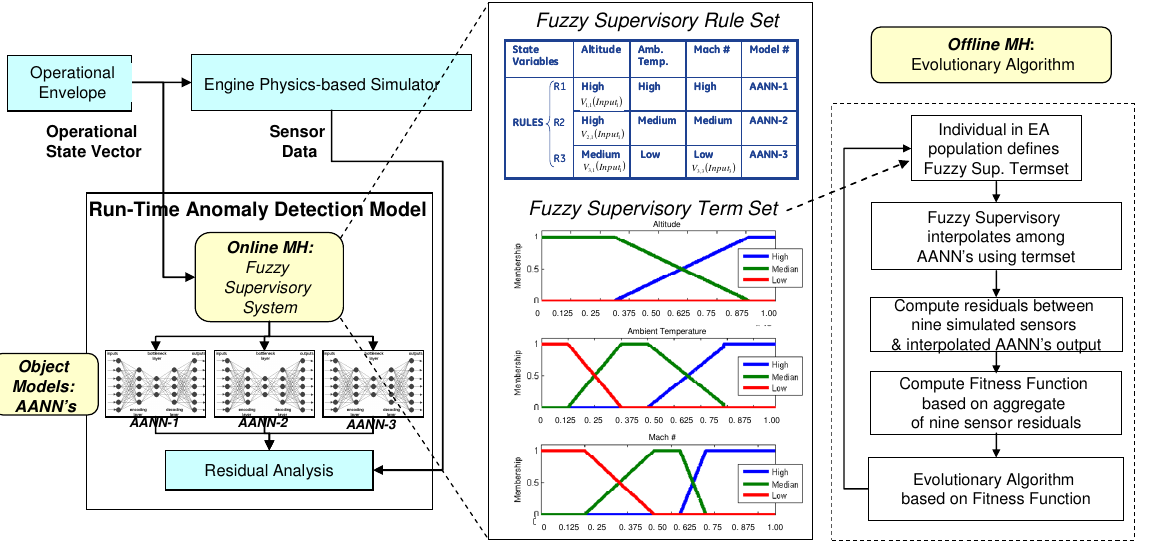
Fig. 8. Offline MH (EA) to tune a run-time AD model composed of an Online MH (Fuzzy Supervisory System) and an ensemble of local object-level models (AANN’s) - (adapted from reference